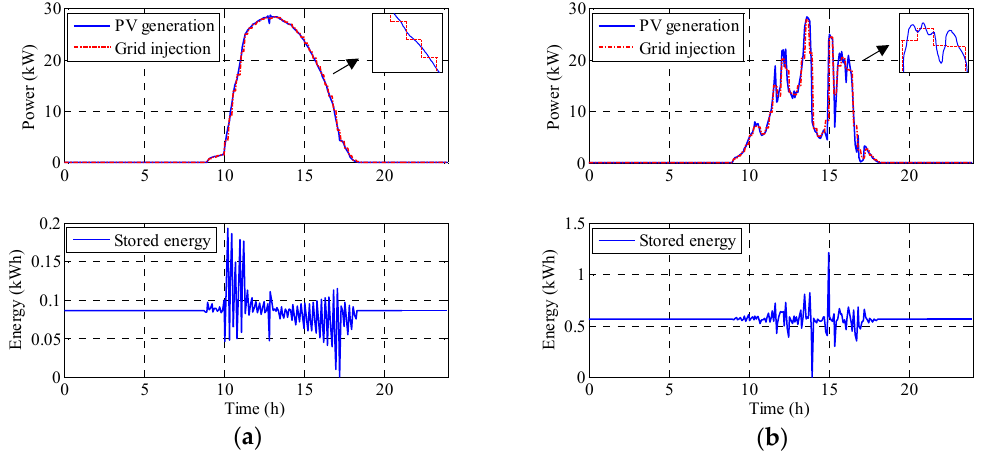
Figure 6. PV power generation, PV power injected into the grid (calculated as an average of the next 15 min interval forecast) and the energy stored: ( a ) for a sunny day and ( b ) for a cloudy day.